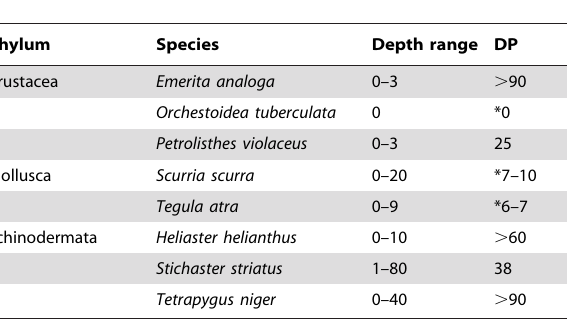
Table 1. Species analyzed and the corresponding depth range in meters that they inhabit, and dispersal potential (DP) as number of days that larvae spend in the water column.